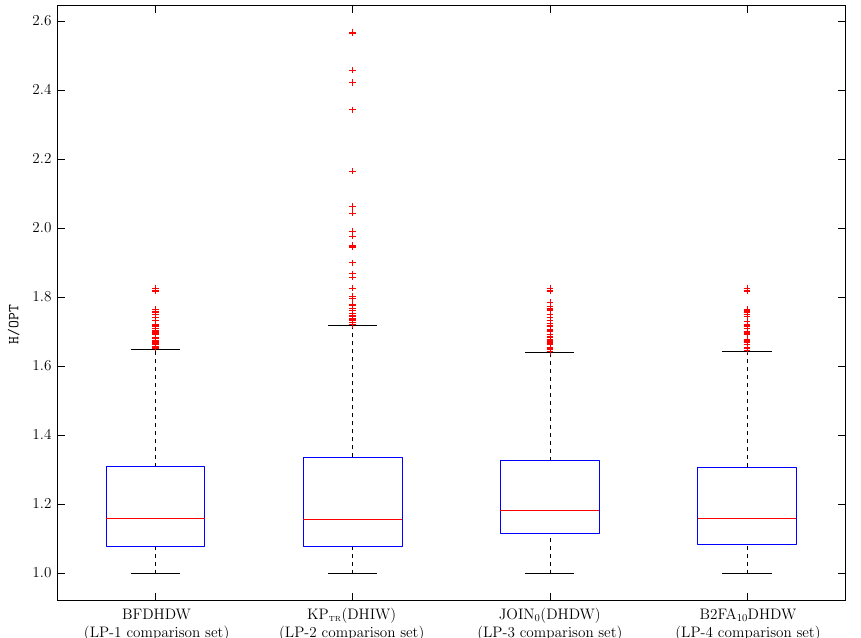
Figure 3: Box plots of the results achieved by the best level-packing algorithm from each of the comparison sets LP-1, LP-2, LP-3 and LP-4 when applied to the 1 170 SPP benchmark instances listed in Table